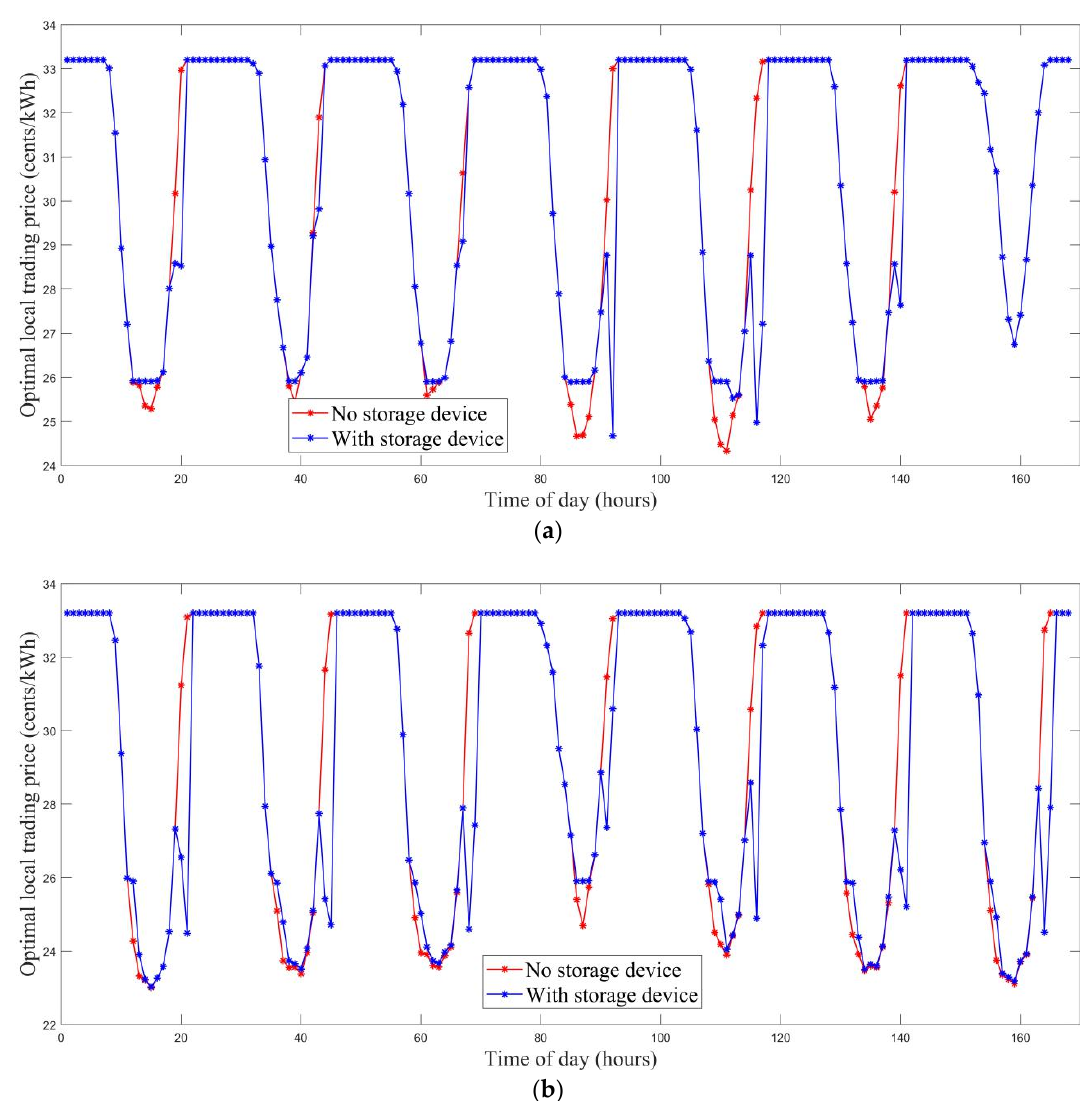
Figure 6. Comparison of the hourly optimal local trading price: ( a ) with low irradiation and ( b ) with high irradiation.